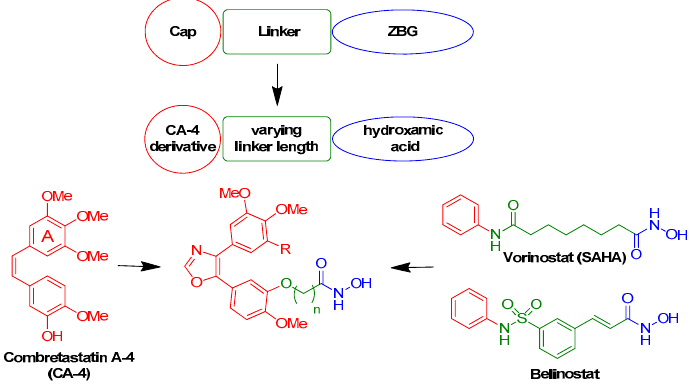
Figure 1. General pharmacophore model of HDACi, structures of the vascular-disrupting agent (VDA) combretastatin A-4 (CA-4) and of the HDACi vorinostat (SAHA) and belinostat as well as the combination of CA-4 derivatives and HDACi in our hybrid compounds.